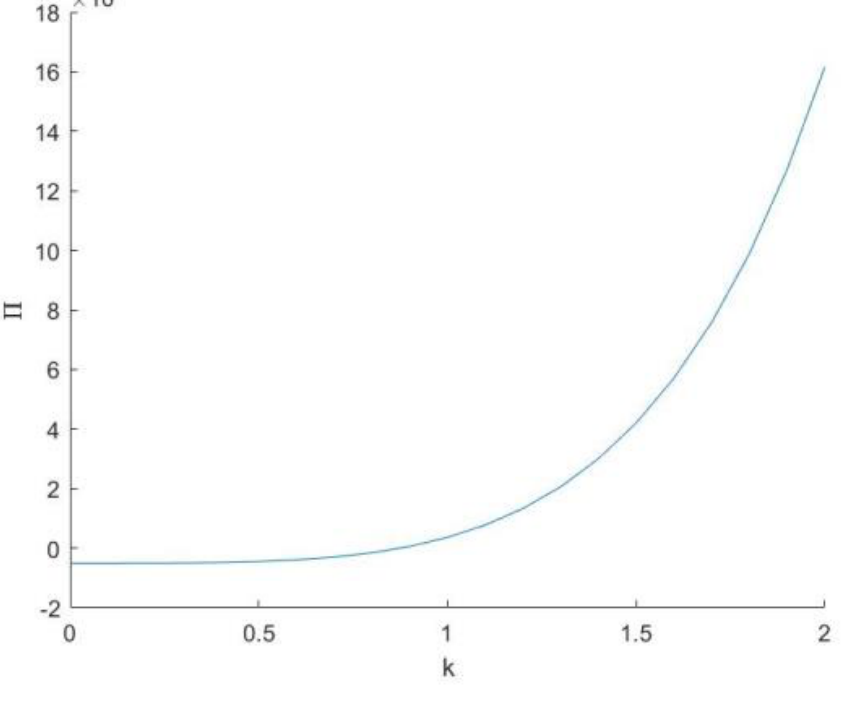
Figure 4. The effect of 𝑘 on 𝛱 ∗ (𝑝 ∗ , 𝑞 ∗ ) .